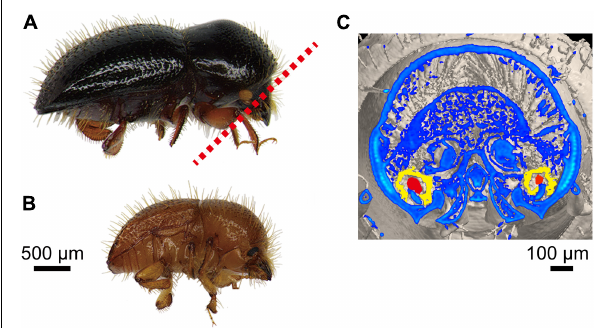
FIGURE 1 | Adult Euwallacea interjectus . (A) Female and (B) male in lateral view. (C) Cross-sections of oral mycangia (colored in yellow) with compacted fungal inoculum (colored in red) in female from red dotted line in panel (A) by micro-computed tomography scan in Jiang et al. (2019) (unpublished image).